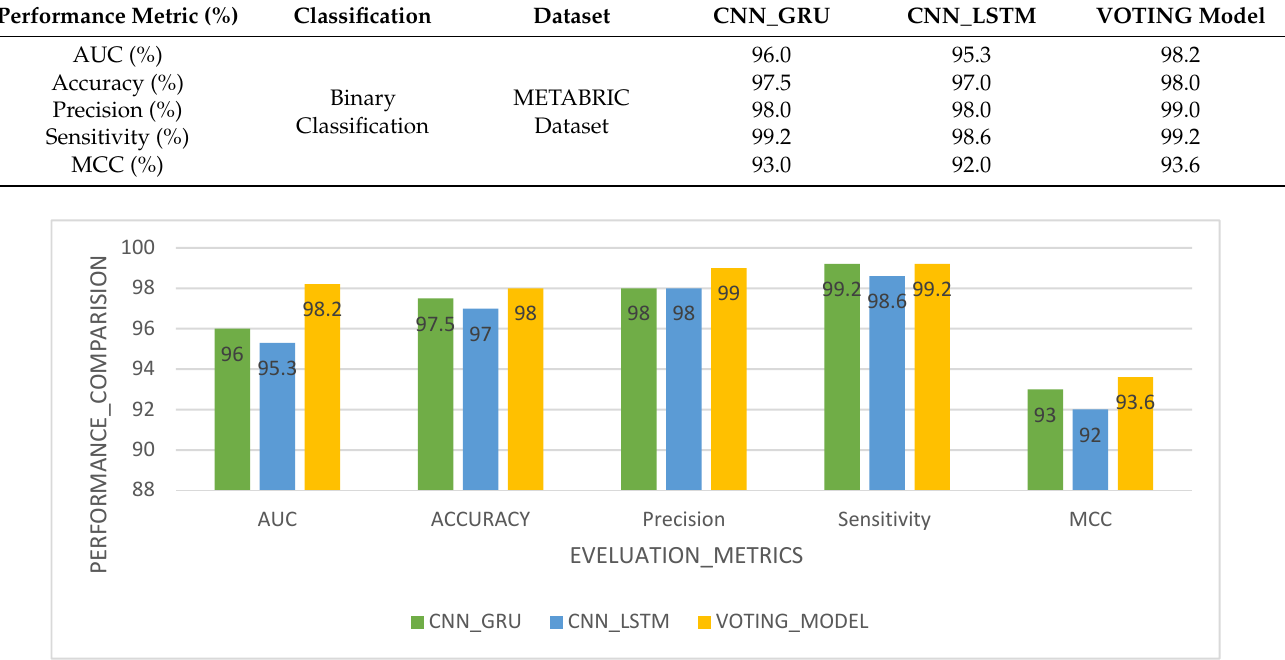
Figure 4. The classification performance of the CNN_GRU, CNN_LSTM, and VOTING models.